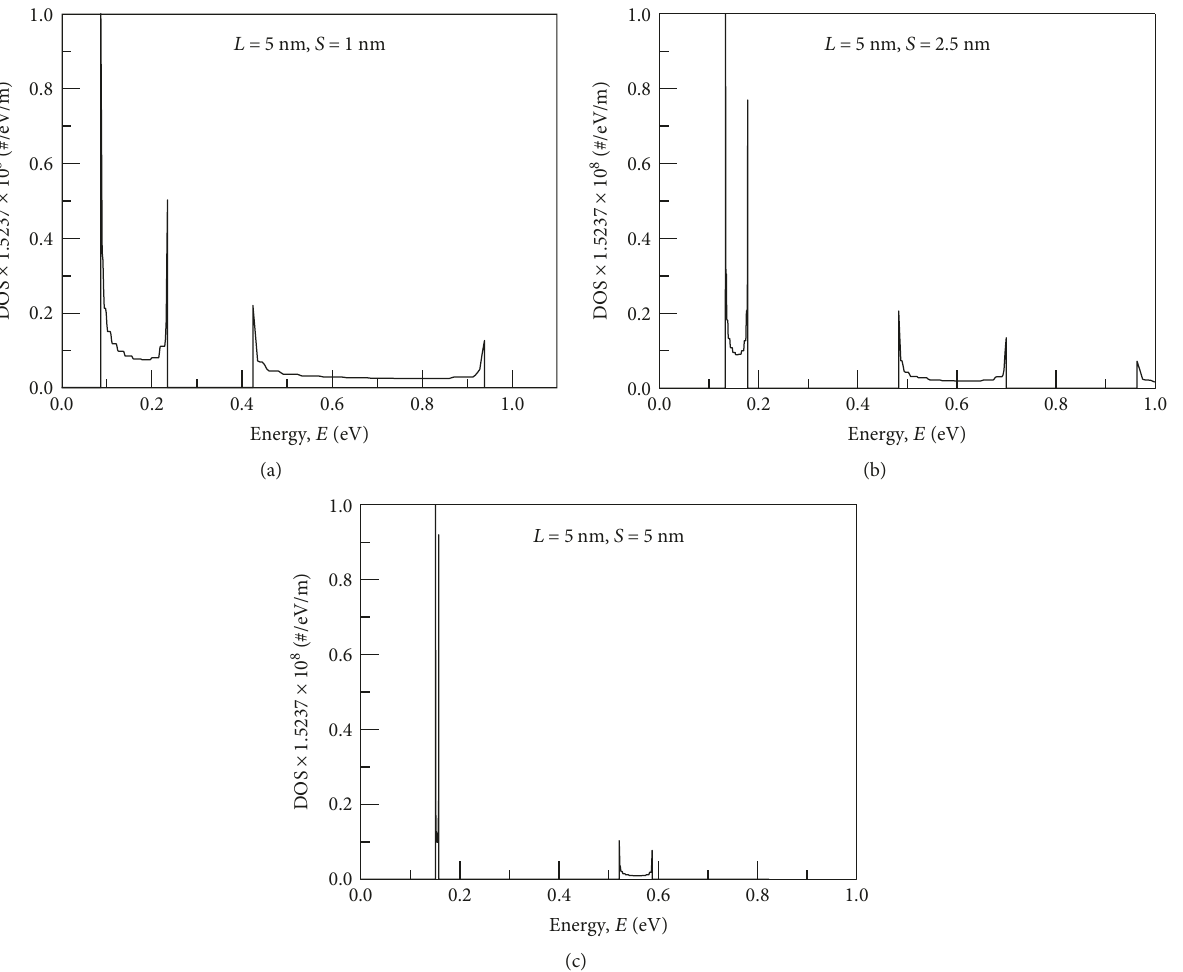
Figure 4: The electron density of states (DOS) in the minibands for dot spacing of (a) 1nm, (b) 2.5nm, and (c)